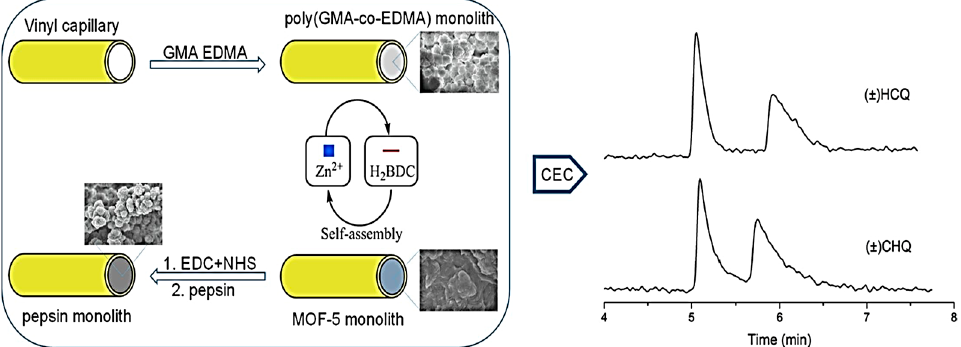
Figure 19. A layer-by-layer self-assembly of MOF-5 and pepsin as a chiral selector to prepare new monolithic capillary columns. Because of the synergistic effect of MOF and pepsin, the developed capillary column could complete the racemate resolution of 6 chiral drugs within 15 min with good repeatability and stability. Layered MOF-5 is the key to enhancing the performance of capillary columns, and its application in CEC is also one of the advanced trends in the future. Reprinted (adapted) with permission from